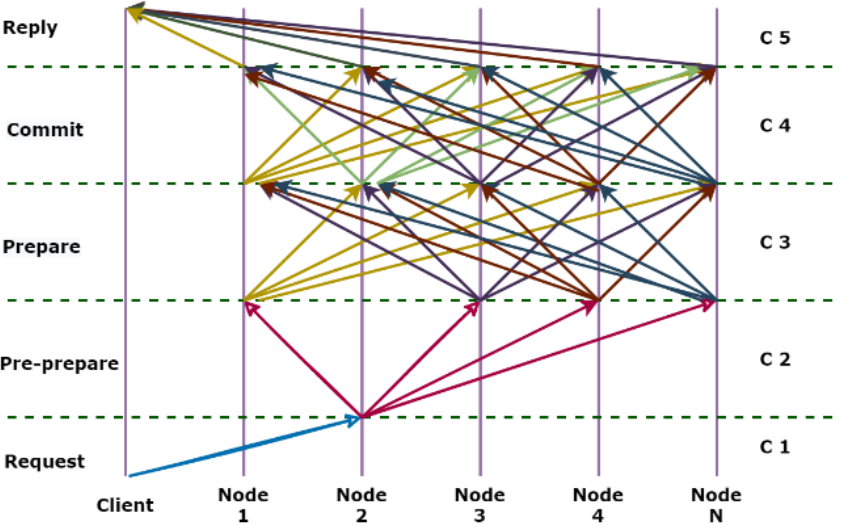
Figure 3. PBFT consensus process, step by step shows how to communicate with each